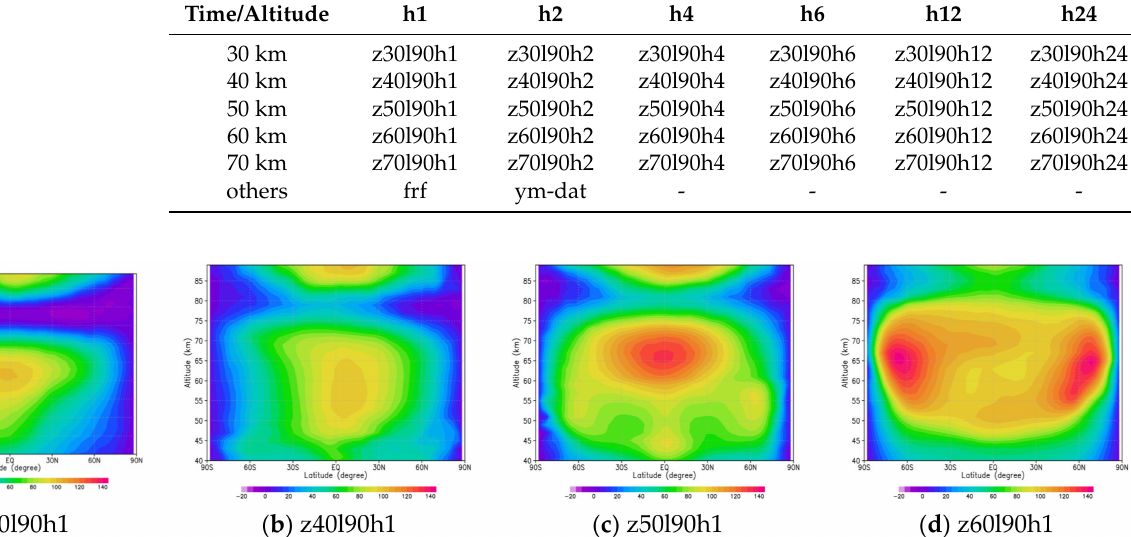
Figure A1. Latitude-altitude cross sections of mean zonal wind for the cases of ( a ) z30l90h1, ( b ) z40l90h1, ( c ) z50l90h1 and ( d ) z60l90h1 (analysis) on 30 January